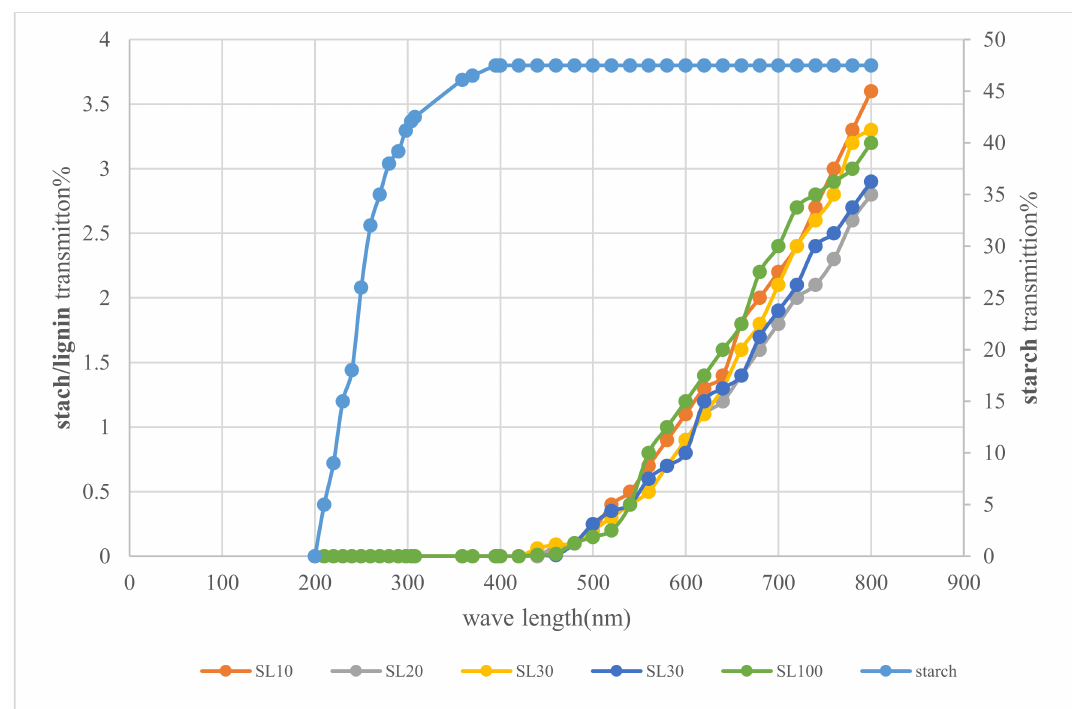
Figure 7. Ultraviolet transmission of neat starch and starch-lignin composite with a different number of grinding